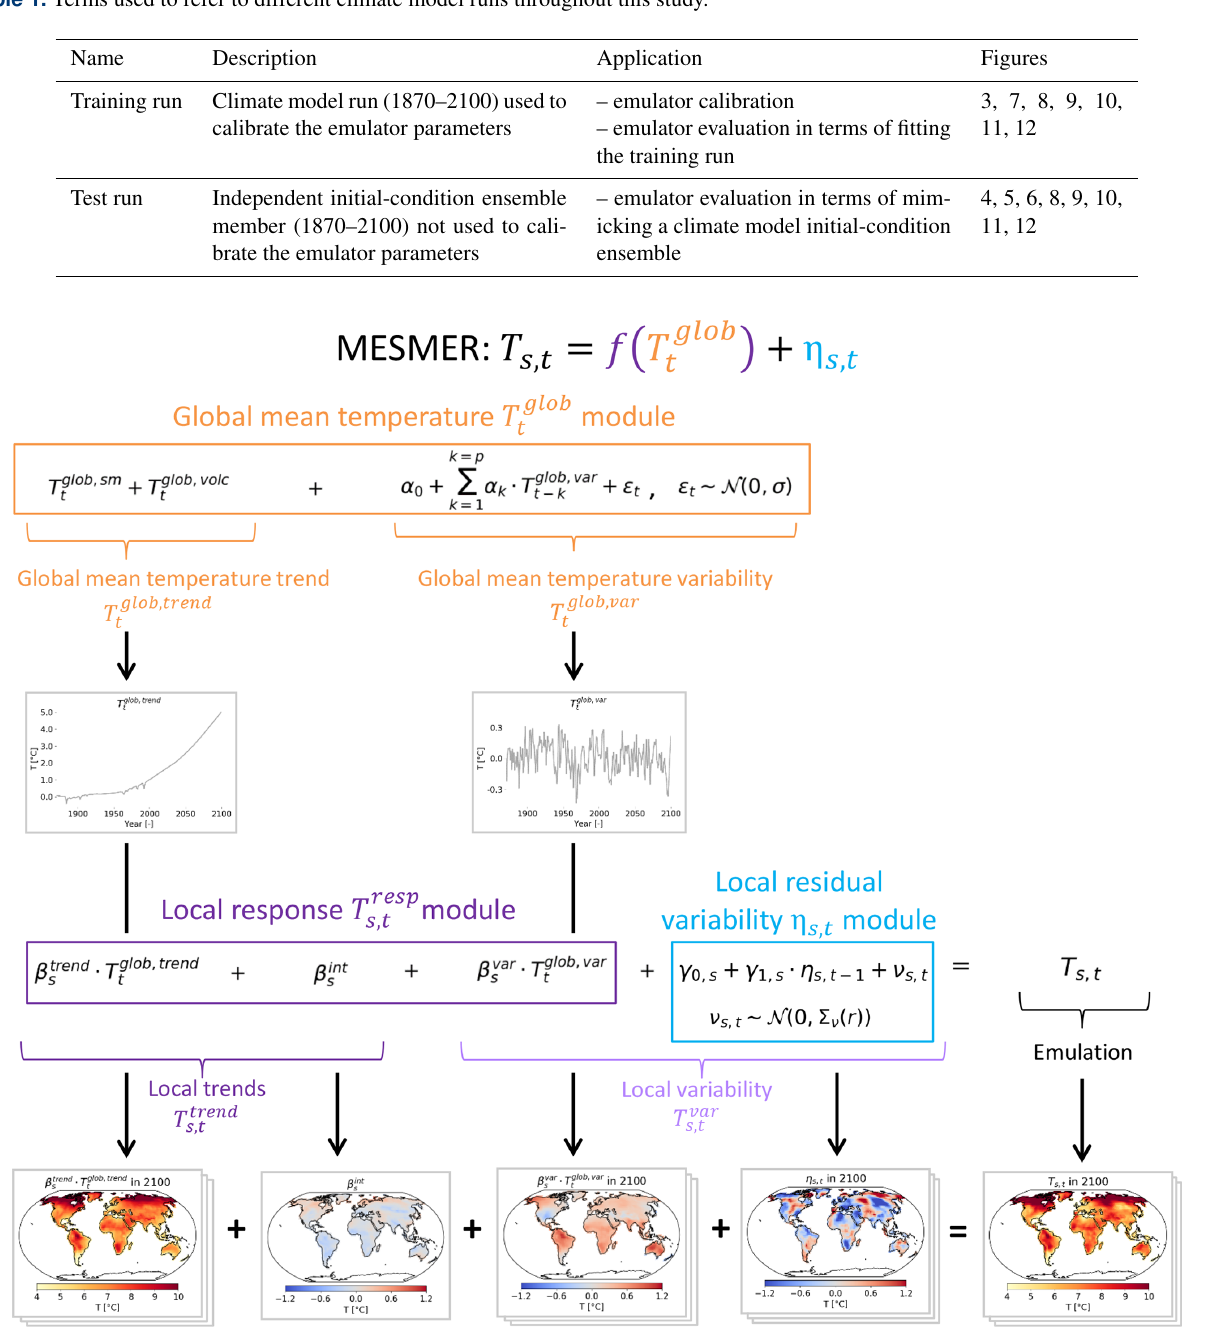
Figure 2. Illustration of the emulation framework with the MESMER implementation.